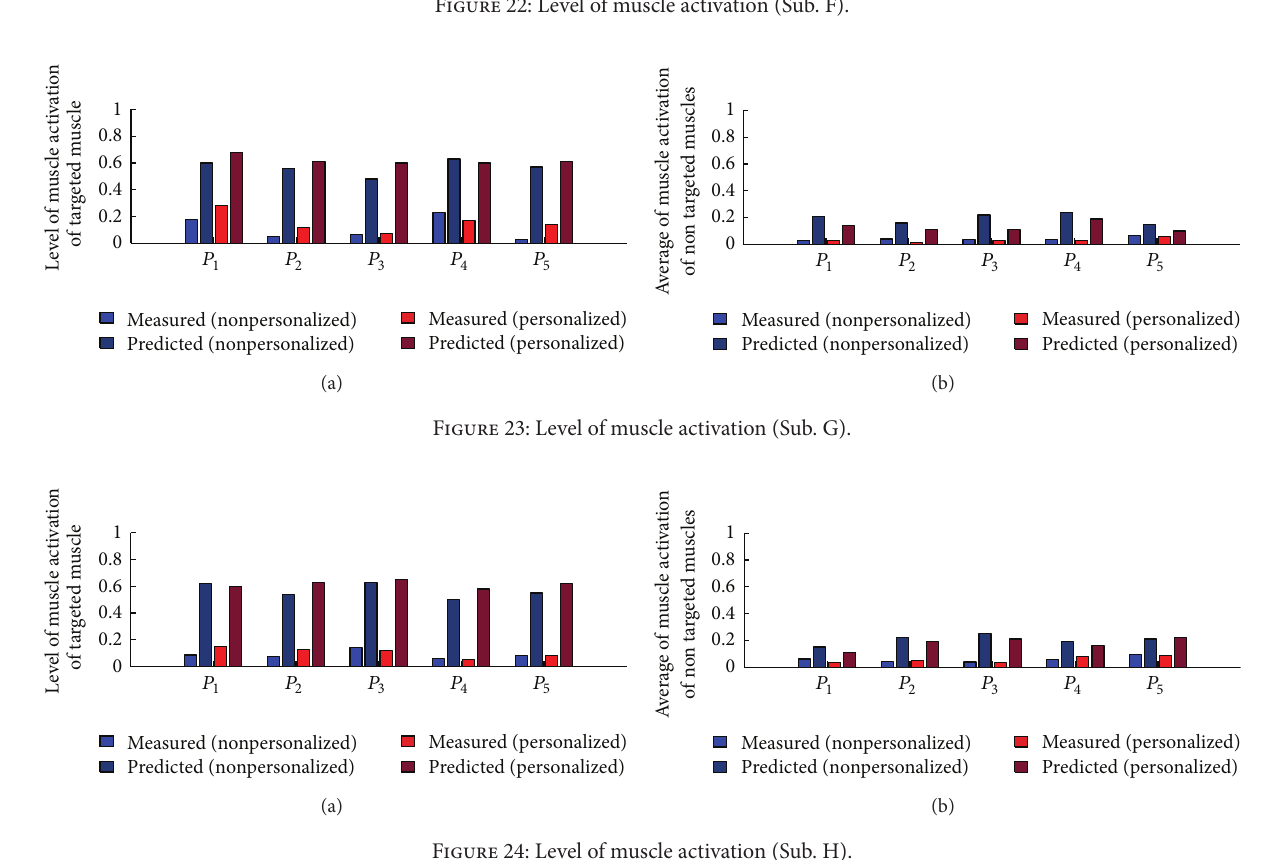
Figure 22: Level of muscle activation (Sub. F).